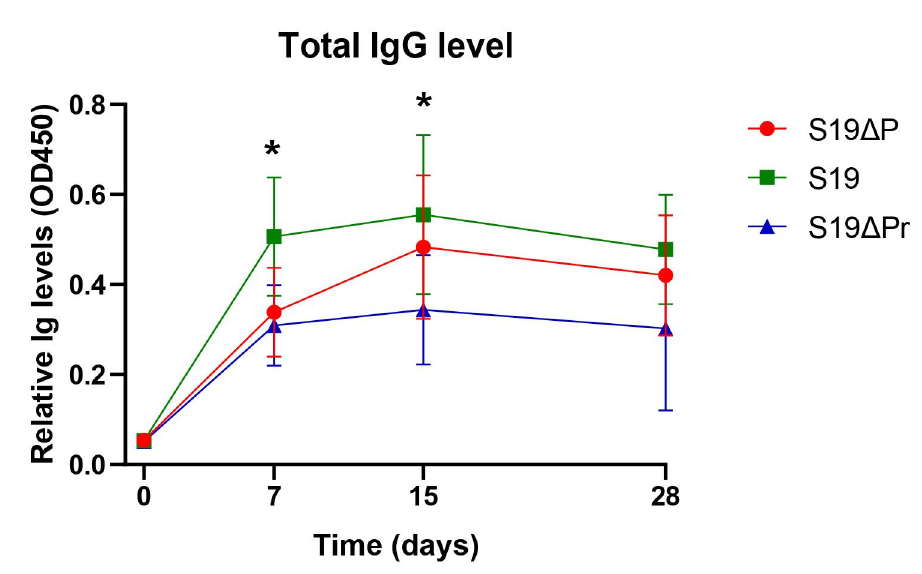
Figure 3. Total IgG levels among immunized buffaloes. Indirect ELISA based quantification of serum IgG concentration was performed. Statistically significant difference (* p < 0.05) was observed between S19 vaccine and candidate mutant vaccines, S19 Δ P (S19 Δ per normal dose) and S19 Δ Pr (S19 Δ per reduced dose). Results are presented as a line diagram with mean ± SD at each time point. The difference in the titer of IgG was noticeable as early as on 7 days post immunization (dpi) and peaked at 15 dpi.